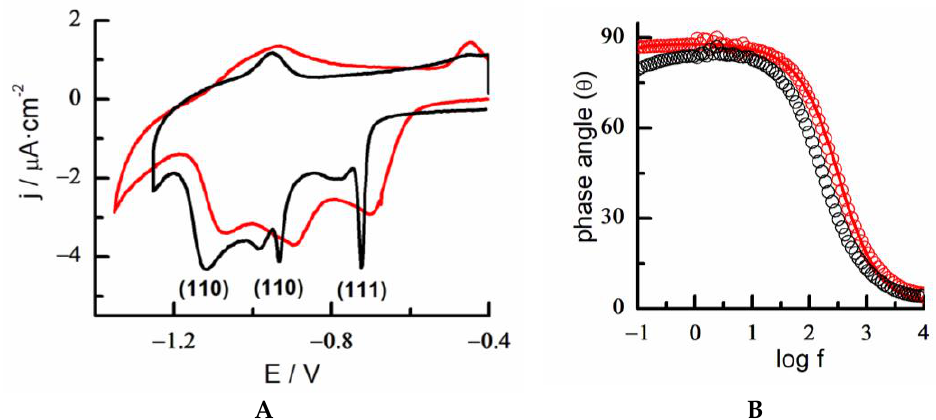
Figure 7. ( A ) Cyclic voltammograms of the reductive desorption of 6MP-SAM in KOH 0.1 M on Au 18K gold alloy plate (red) and polyfaceted gold bead (black). Scan rate 0.02 V/s. ( B ) Electrochemical impedance spectra. Bode plot of a 1 × 1 cm 2 square plate of 18K gold alloy. Variation of the phase angle with the frequency of the bare alloy (black circle) and 6MP-SAM/alloy (red circle). E dc = − 0.3 V. Fitting of experimental data to a [R(RQ)] equivalent circuit (red line).